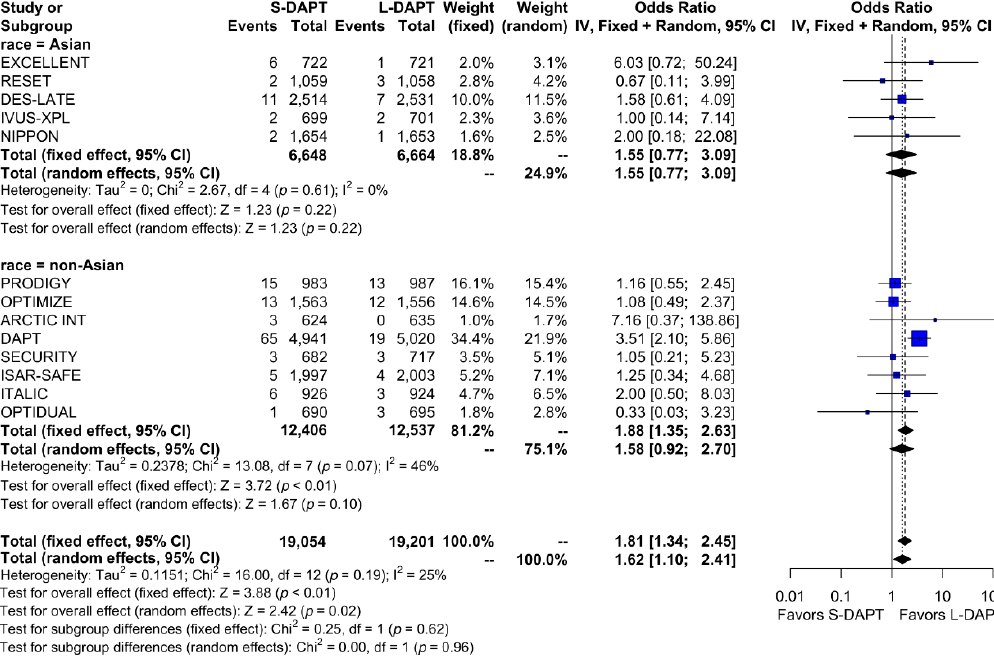
Figure 6. Stent thrombosis in randomized clinical trials. S-DAPT, short duration dual antiplatelet therapy; L-DAPT, long duration dual antiplatelet therapy; CI, confidence interval.